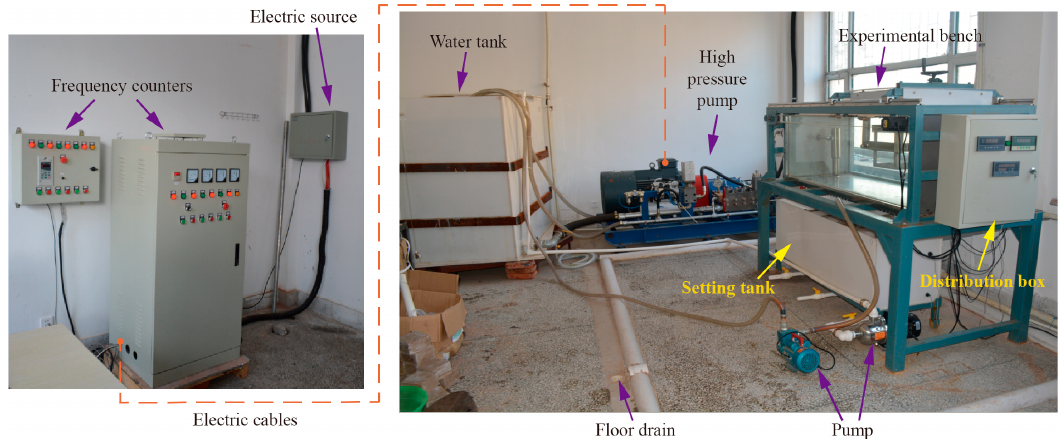
Figure 5. The multifunctional experimental device for testing the performance of the high-pressure water jet breaking oil shale.